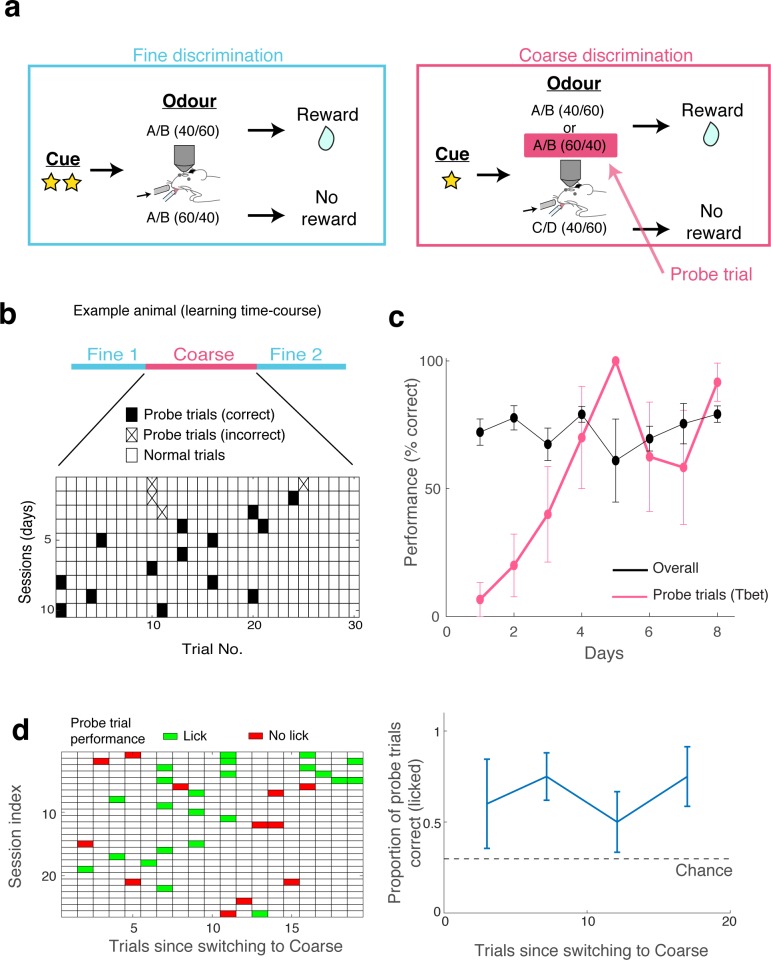
Task-switch learning and probe trials.(A) Behavioural paradigm for task switching. Mice are trained to perform fine discrimination blocks before and after a coarse discrimination block within one session. The design of the coarse discrimination is such that mice are forced to generalise closely related odours. On a given rewarded (S+) trial, the odour was either A/B in a 40/60 mixture or A/B in a 60/40 mixture. This latter stimulus appears as the non-rewarded odour in the fine discrimination session. Therefore, the A/B (60/40) trial during the coarse discrimination block serves as a test to see whether mice genuinely perform tasks differently, so they are termed ‘Probe trials.’ (B) A typical example showing the performance of a mouse during the probe trials over several days (one session per day). Trials during coarse discrimination are shown as tiles. Probe trials with an incorrect response (i.e., no lick) are marked with a cross, while those with a correct response are shown as filled tiles. (C) On average, mice learned to perform task-switching in 4 days, as seen in the performance accuracy in these probe and overall trials. N = 5 mice for Tbet-Cre x Ai95D experiment (average of 1.6 ± 0.4 trials per mouse per session). (D) Switch performance for all trials used in the imaging sessions (five mice). Trials are shown from the time of switching from fine discrimination epoch one to coarse discrimination. Left: The lick performance for each probe trial is colour-coded, where green indicates the presence of lick (significantly more than during the baseline period, based on Poisson distribution of lick count during the baseline period), and red indicates the absence of lick in response to α’-odour presentation. Right: Summary showing the average lick performance on probe trials binned into 4 phases of coarse discrimination epoch. Chance level is the average probability of observing a lick in response to a’-odour during fine discrimination epochs. Mean and s.e.m. shown (average of zeros and ones, with each point reflecting approximately seven trials).